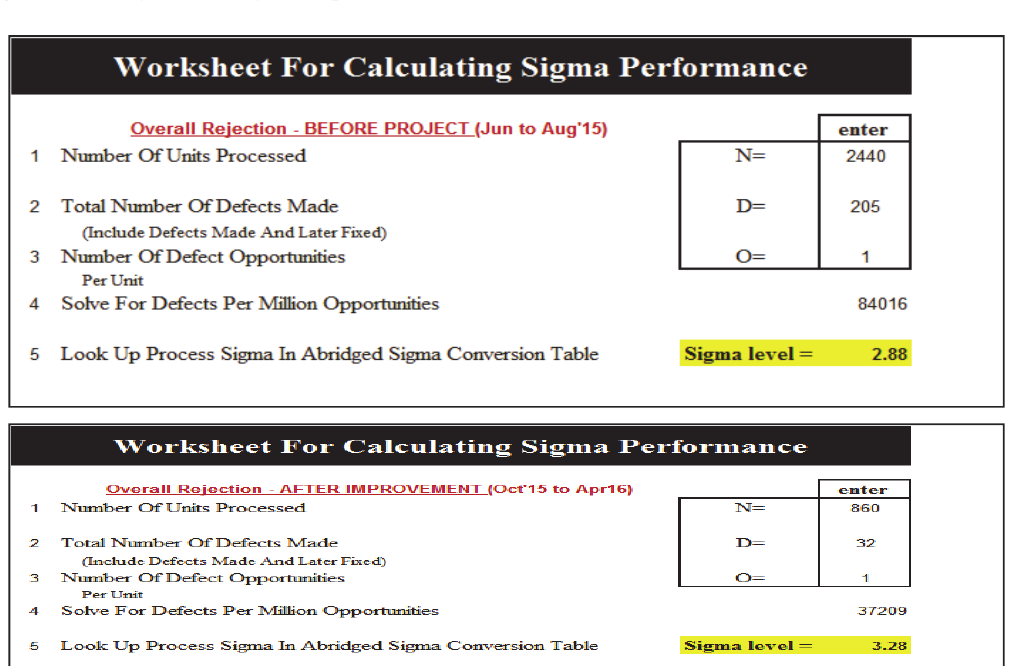
Fig. 14. Sigma Level of Overall rejection (Before & Full scale Run)